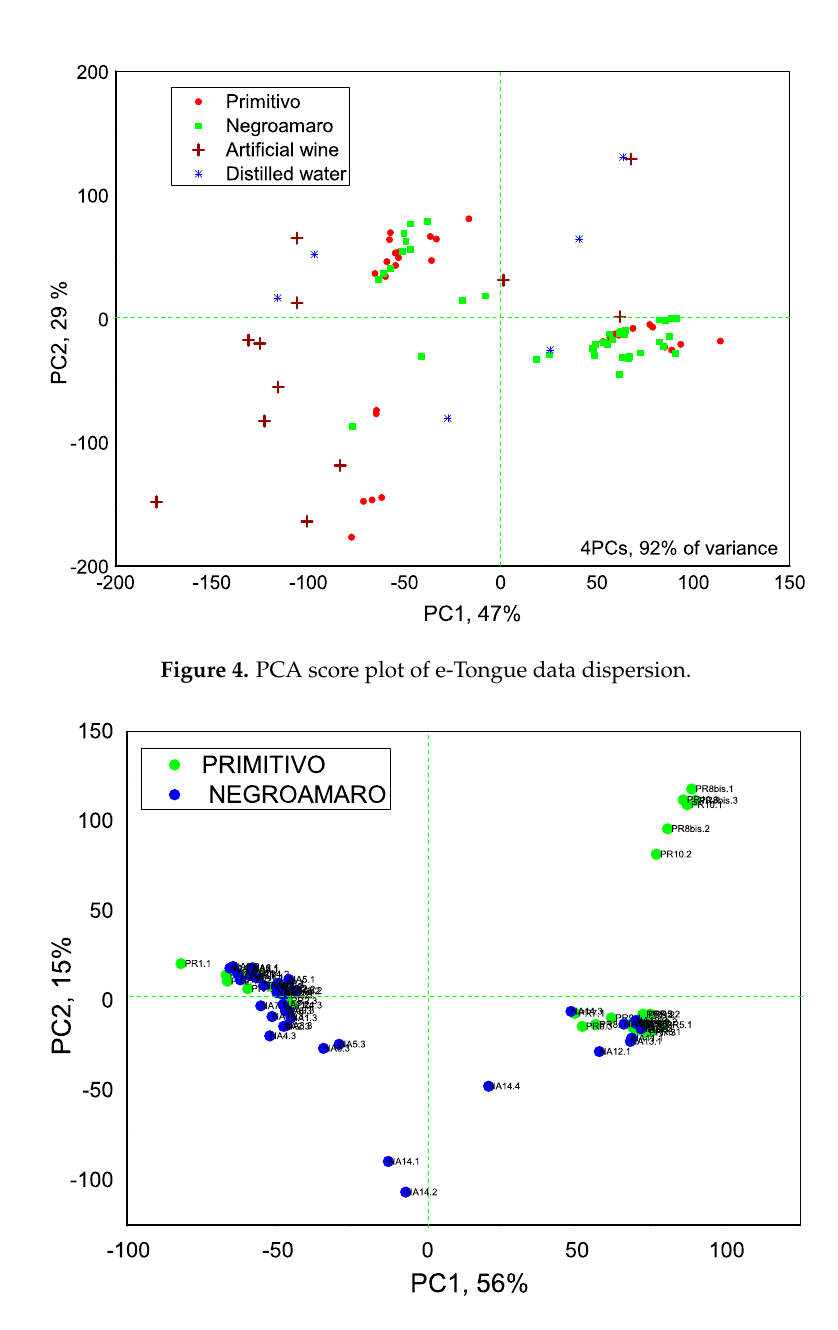
Figure 5. PCA-DA score plot of Primitivo and Negroamaro wines discrimination. Table 4. PLS-DA confusion matrix of Primitivo and Negroamaro wines classification obtained by cross validation procedure.